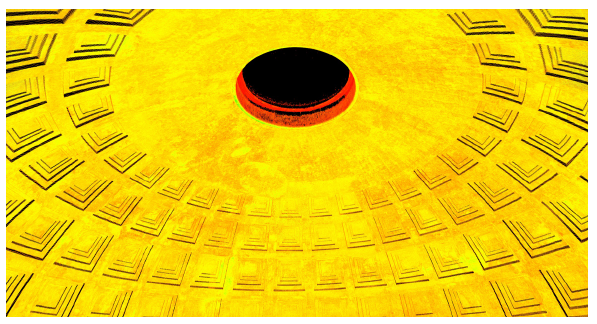
Figure 3. View of the point